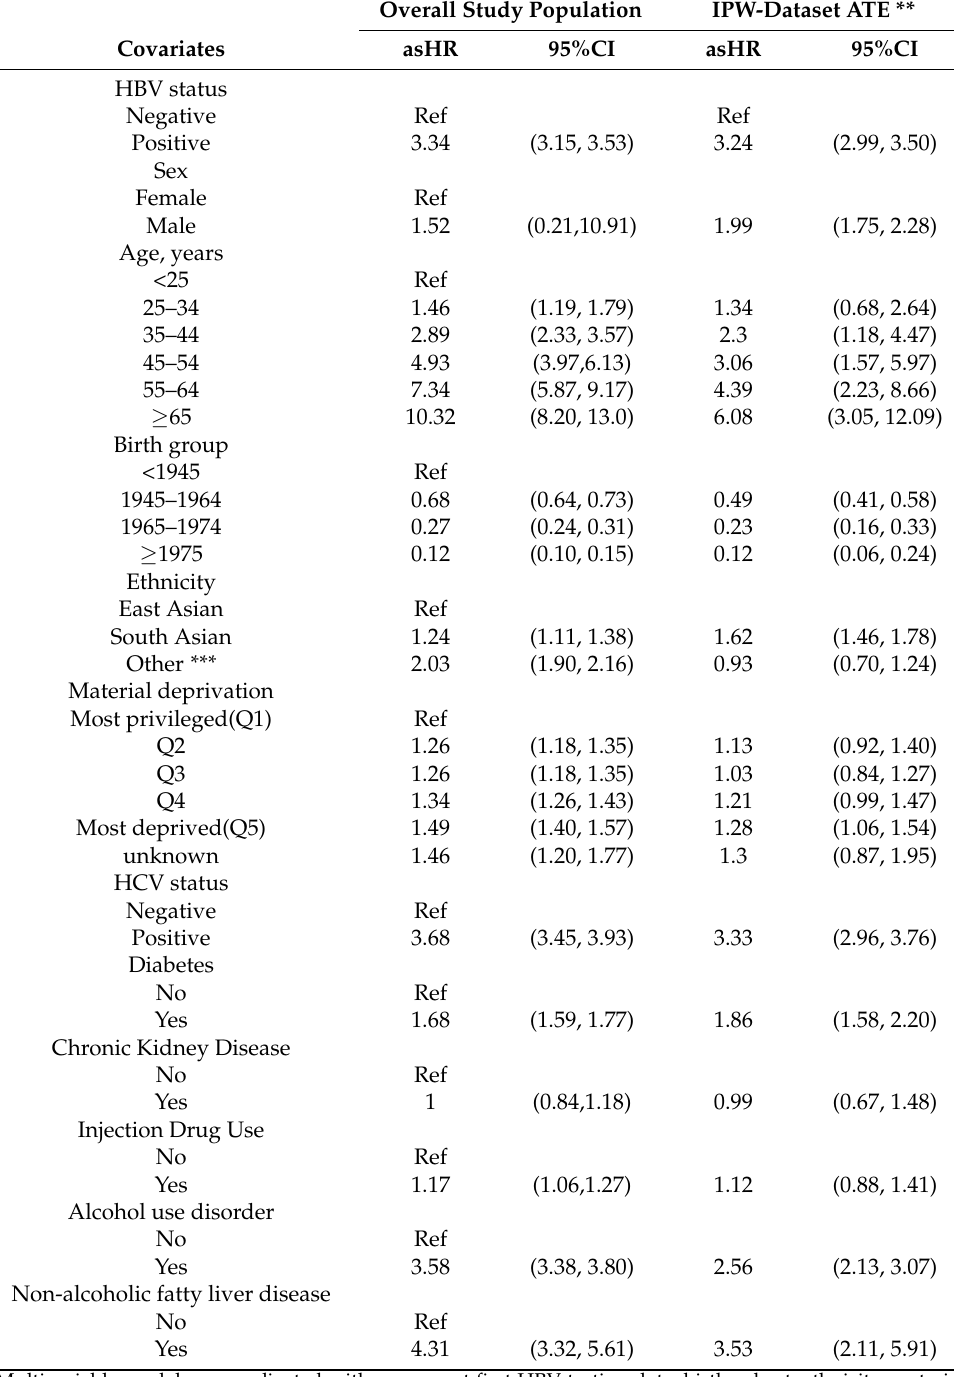
Table 2. Impact of HBV infection on liver-related mortality between 1990–2015 in the British Columbia Hepatitis Testers Cohort, using multivariate * analysis Cox regression